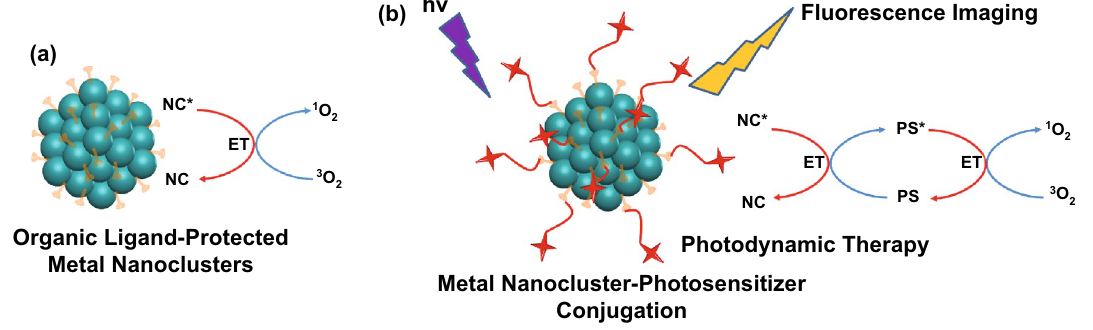
Fig. 6 a Organic ligand-protected metal nanocluster for singlet oxygen generation. b Metal nanocluster-photosensitizer conjugation as multi- functional nanomaterial for simultaneous florescence imaging and photodynamic therapy. Nanocluster acts as donor and PS acts as acceptor in the energy transfer (ET)